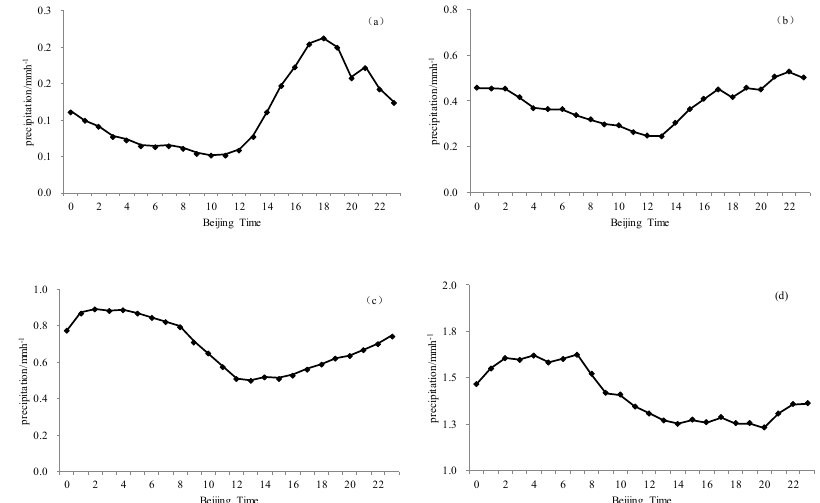
Figure 8. The diurnal variations of the di ff erent duration precipitations in the Haihe River basin, 2007–2017 (( a ), short-duration (1–3 h) precipitation; ( b ), medium-duration (4–6 h) precipitation; ( c ), long-duration (6–12 h) precipitation; and ( d ), continuous precipitation (over 12 h)